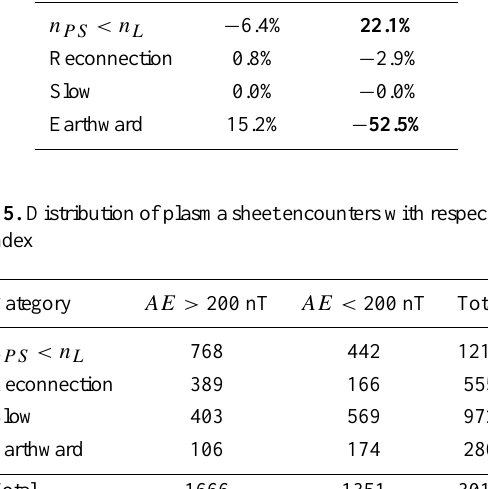
Table 6. Relative differences from expected values with respect to AE index: slow flows are more likely to be observed during quiet times, and reconnection flows are more likely to be observed in ac- tive times. Earthward flows are also more likely to be observed during quiet times, while n PS < n L are more likely to be observed during active times Category